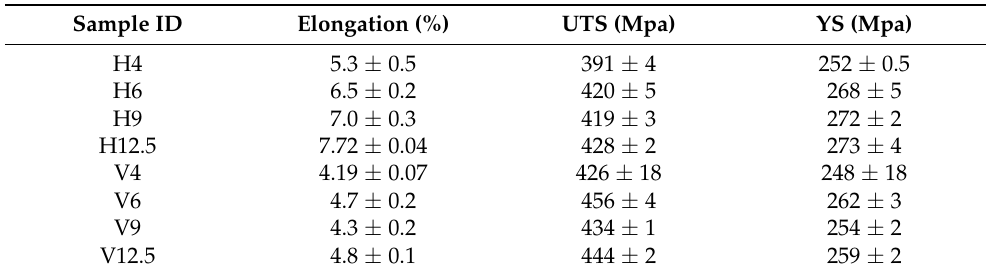
Table 2. Elongation, Ultimate tensile strength, and Yield strength values of horizontally and vertically built tensile